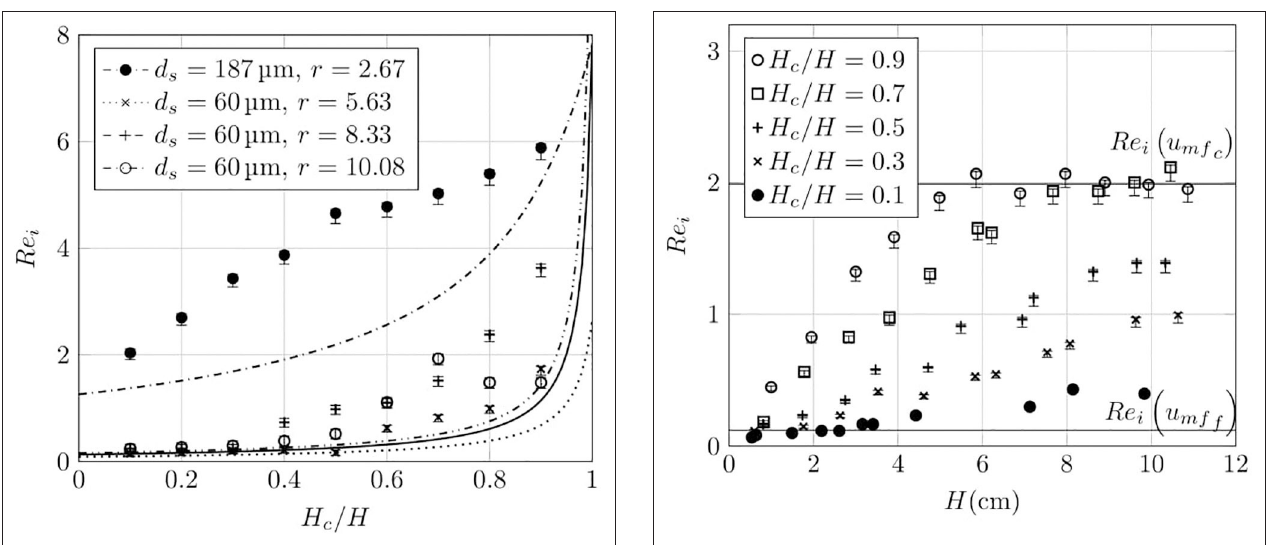
FIGURE 7 | Variation of the Reynolds number of the large particles at the point of initiation of the formation of a pocket in the lower, fine particle layer of the bed. The initial thickness of the bed was 10 cm for all the beds. Curves are Equation (10), which relates Re and H c / H at u = u mf ; points are experimental measurements.